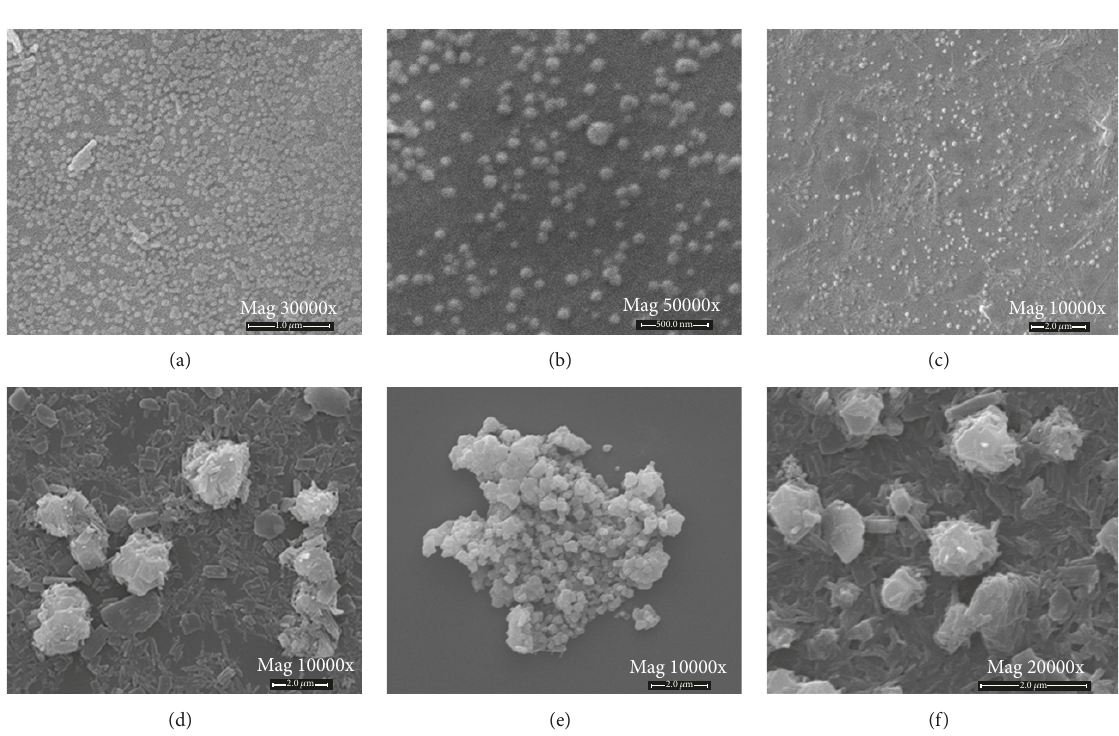
Figure 3: SEM images of HCPTNPs using sodium taurocholate as surfactants under different HP and amount conditions: (a) 0.5 mg, 600 bar; (b) 0.5 mg, 800 bar; (c) 0.5 mg, 1000bar; (d) 2.5 mg, 600 bar; (e) 2.5 mg, 800 bar; (f) 2.5 mg, 1000bar.